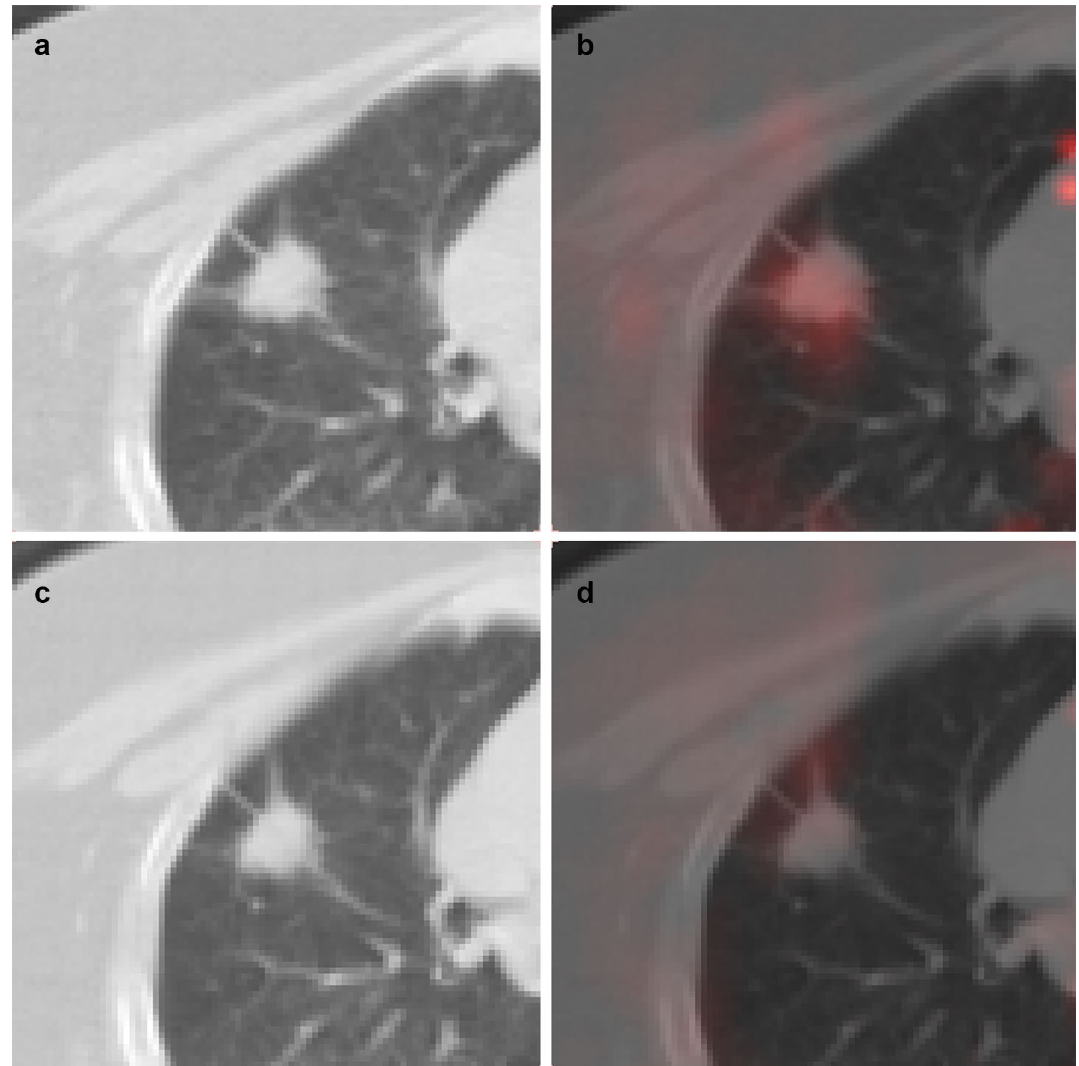
Figure 5. 15 O-water positron emission tomography of a 67-year-old woman with adenocarcinoma treated with bevacizumab (patient no. 2). ( a,b ) CT and fusion image of CT and parametric image of blood flow at baseline. ( c,d ) CT and fusion image after chemotherapy. CT depicted a 2.6-cm nodule in the right lung. Tumor blood flow was markedly reduced, from 0.256 mL/cm 3 /min to 0.059 mL/cm 3 /min (blood flow ratio 0.23). Three months later the tumor exhibited